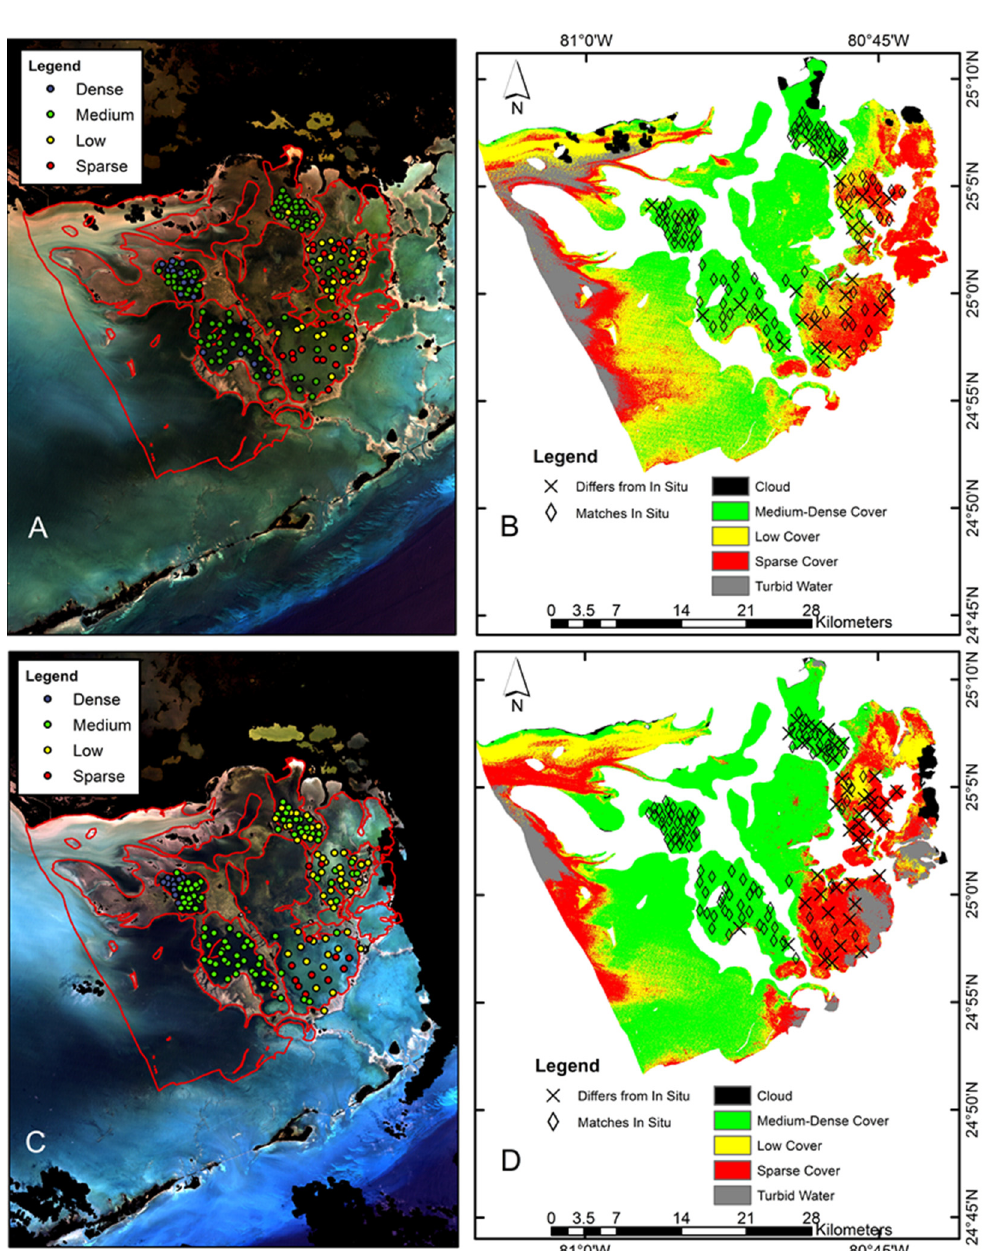
Figure 4. ( A ) 2007 true color composite of the study area showing in-situ data; ( B ) 2007 seagrass cover mapping product showing coherence with in-situ data; ( C ) 2008 true color composite of study area showing in-situ data; ( D ) 2008 seagrass cover mapping product showing coherence with in-situ